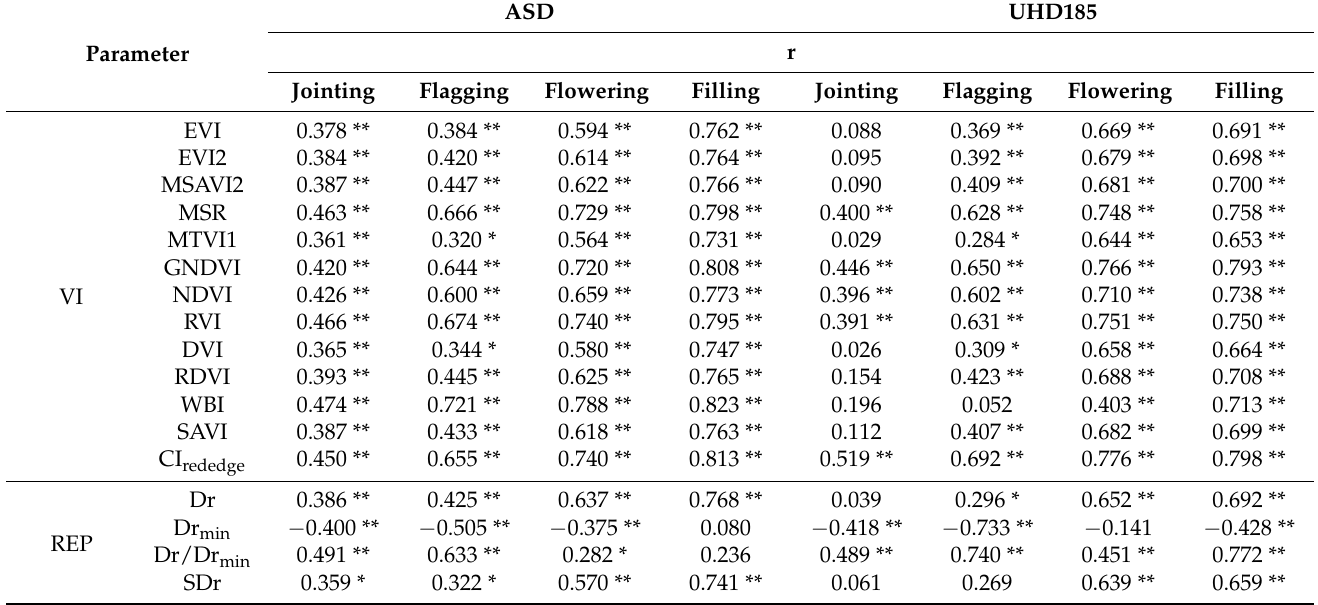
Table 3. Correlation coefficients (r) between the measured yield and various VIs and red-edge parameters based on ASD and UHD185 data.